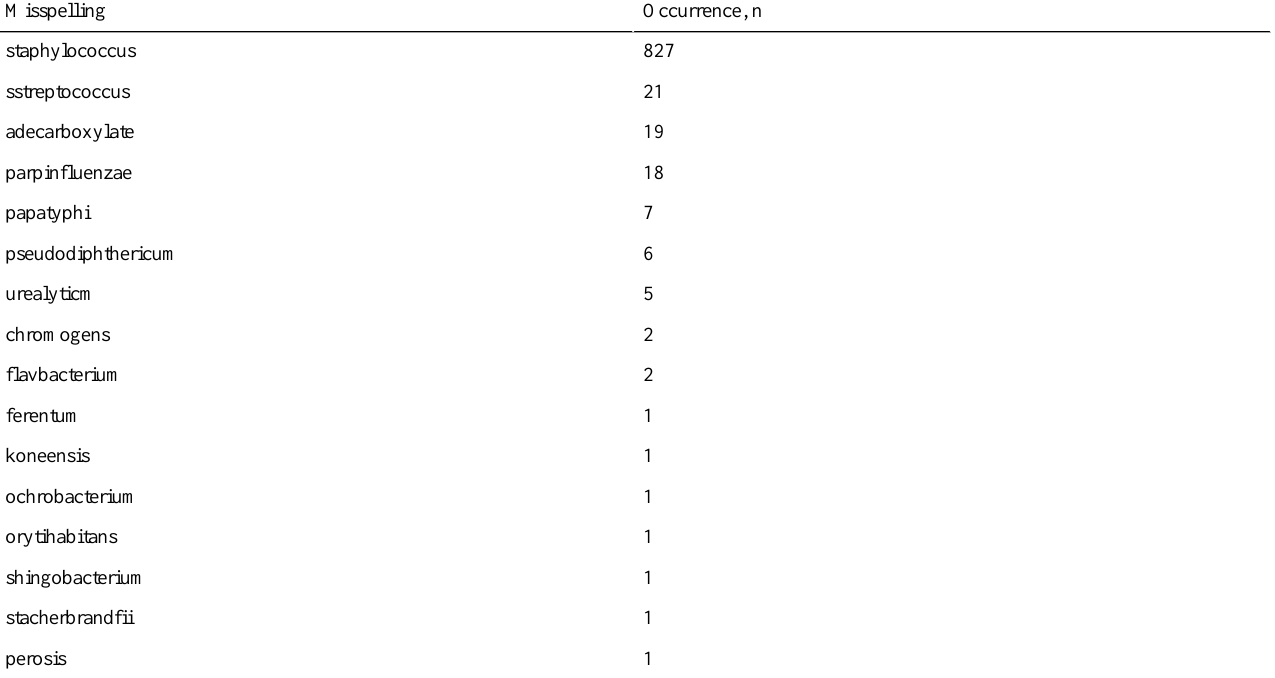
Table 1. Misspelling frequency table.